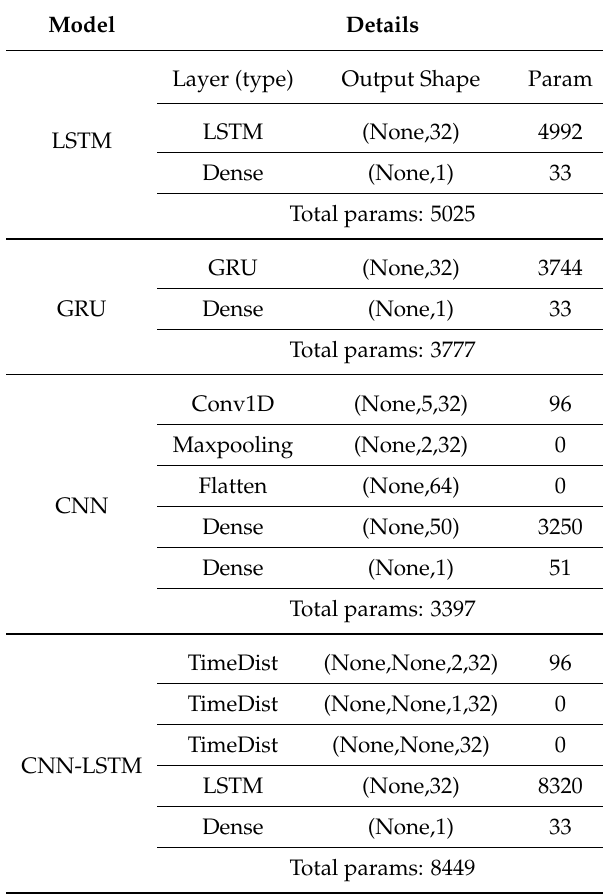
Table 2. Elaboration of the neural network structures.